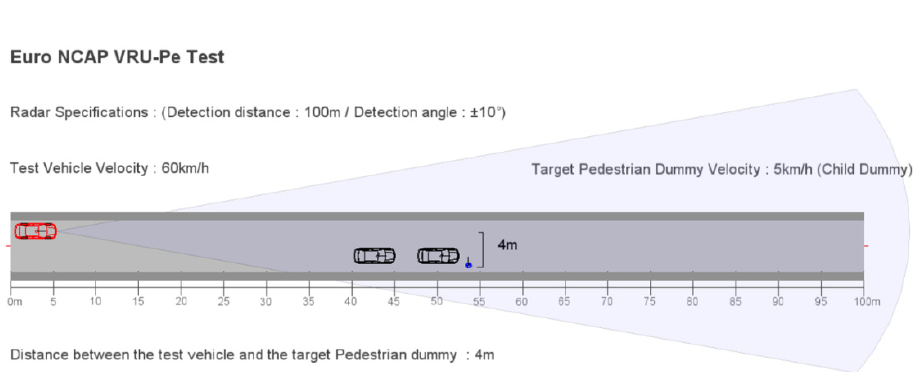
Figure 11. Euro NCAP inter-urban scenario.